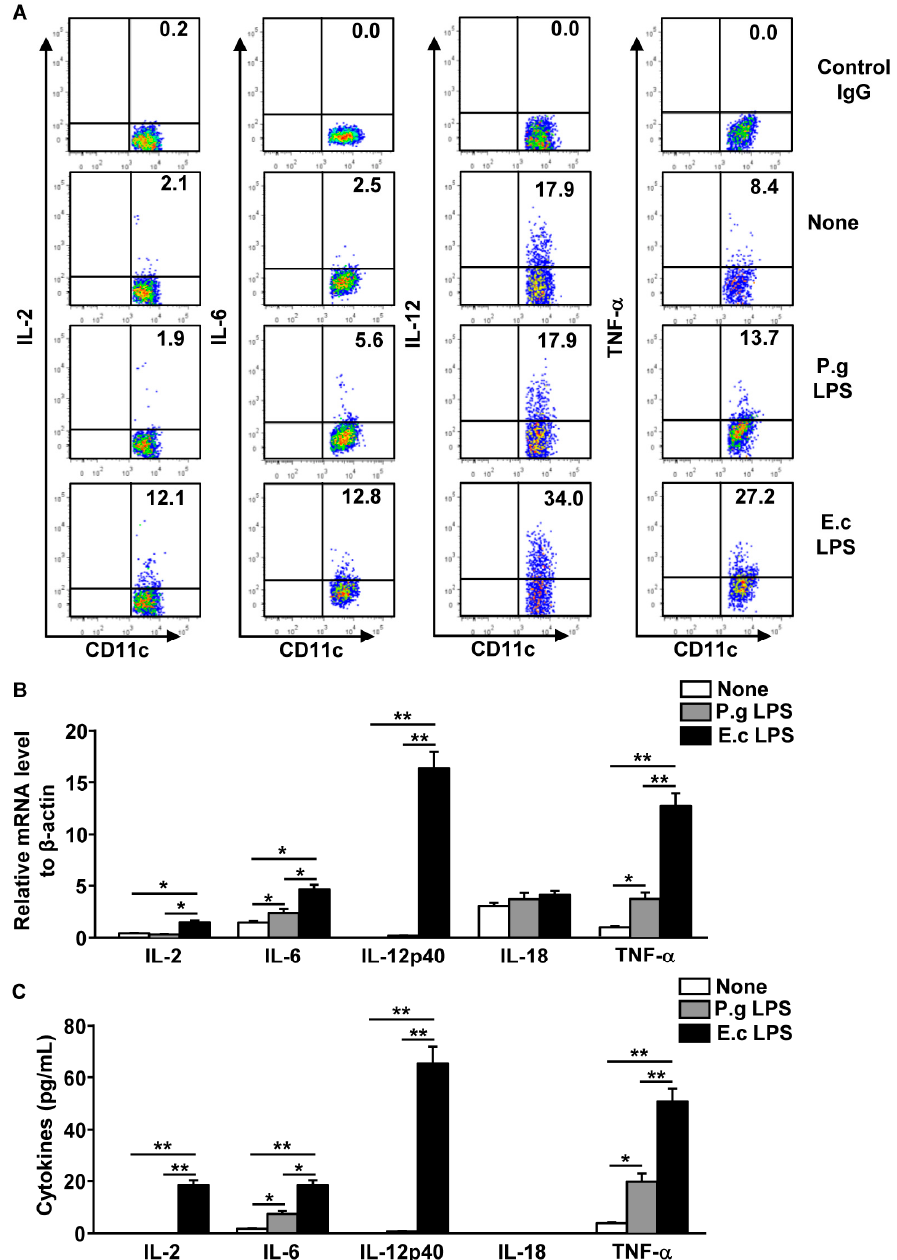
Figure 4. P. gingivalis LPS weakly induced pro-inflammatory cytokine production in spleen DCs. C57BL/6 mice were injected i.v. with 1 mg/kg of P.g LPS or E.c LPS. ( A ) Four hours after injection, the spleen was harvested from the mice and 1 × 10 6 splenocytes were further incubated with monensin for an additional 2 h. Levels of intracellular cytokine production in the spleen DCs were analyzed by flow cytometry; ( B ) CD11c + spleen DCs were isolated 6 h after injection, and measured to mRNA levels of pro-inflammatory cytokines were measured; ( C ) The isolated spleen DCs (0.1 × 10 6 ) were cultured in 1 mL of RPMI-1640 for 4 h in vitro. The concentrations of indicated cytokines were measured in the cultured medium by ELISA. All data are representative of or the average of analyses of six individual mice in each group (two mice per experiment, total three independent experiments). * p < 0.05, ** p < 0.01.